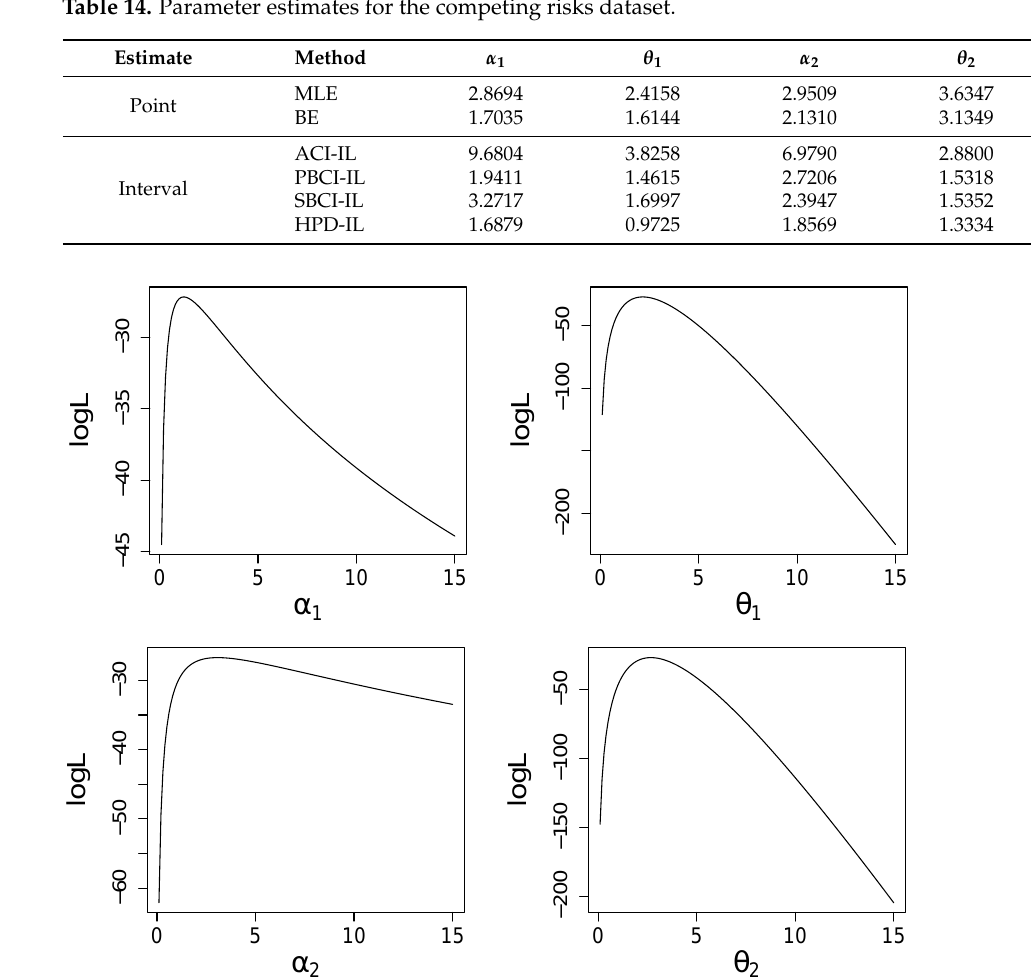
Figure 1. The log-likelihood functions of ( α 1 , θ 1 , α 2 , θ 2 ) for the simulated dataset. Further, using the MLEs, bootstrap samples and MCMC, we can compute the estimates of the reliability and hazard rate given a specified argument x in Equations (5) and